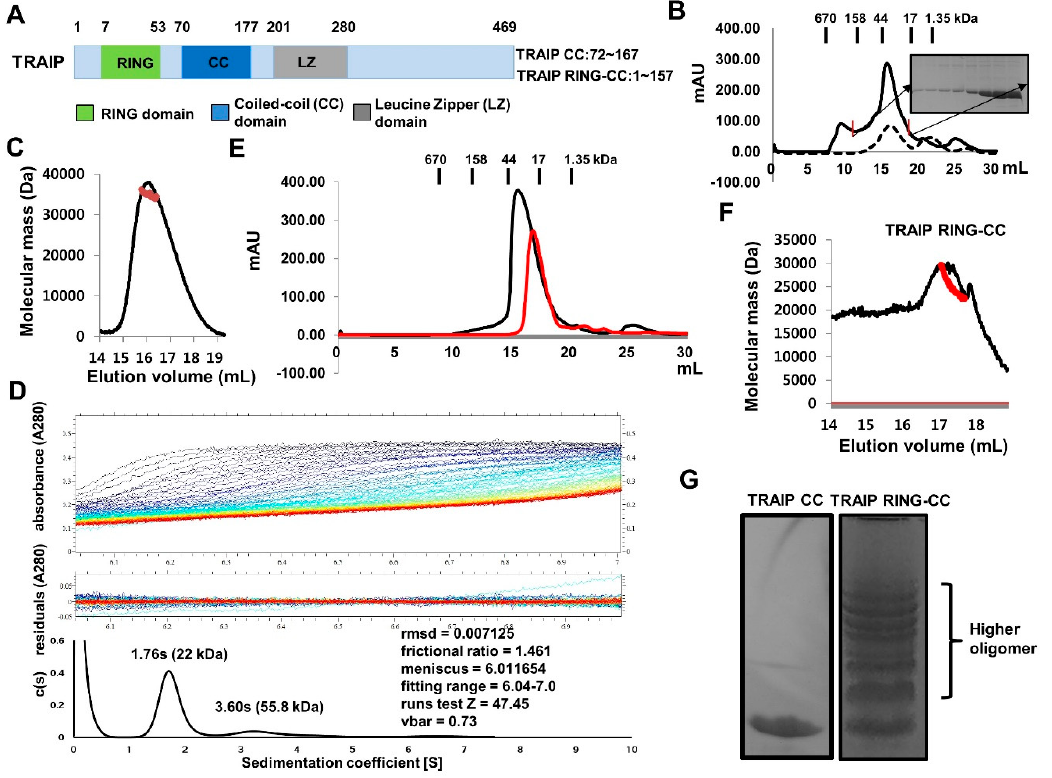
Figure 1. Trimeric TRAF-interacting protein (TRAIP) coiled-coil domain can form higher-order assemblies via RING domain. ( A ) The domain boundary of TRAIP. The number of amino acids of TRAIP coiled-coil (CC) and TRAIP RING-CC constructs used in this study is shown; ( B ) Comparison of size-exclusion chromatography profile between TRAIP CC (dashed-line) and TRAIP RING-CC (solid line); ( C ) Multi-angle light scattering (MALS) result for TRAIP CC. The red line indicates the experimental molecular weight; ( D ) Analytical ultracentrifugation analysis of TRAIP CC. Analytical ultra-centrifugation (AUC) experiment yielded a mass of 22 kDa (sedimentation coefficient of 1.76 s and a fractional ratio of 1.461); ( E ) Comparison of size-exclusion chromatography profile of two different concentrations of TRAIP CCs, which are a highly concentrated protein sample (Black line) and a low concentration of the protein sample (Red line); ( F ) MALS result for TRAIP RING-CC; ( G ) Native PAGE. Ladder-like bands indicating higher oligomer of TRAIP RING-CC is shown with curly brackets.